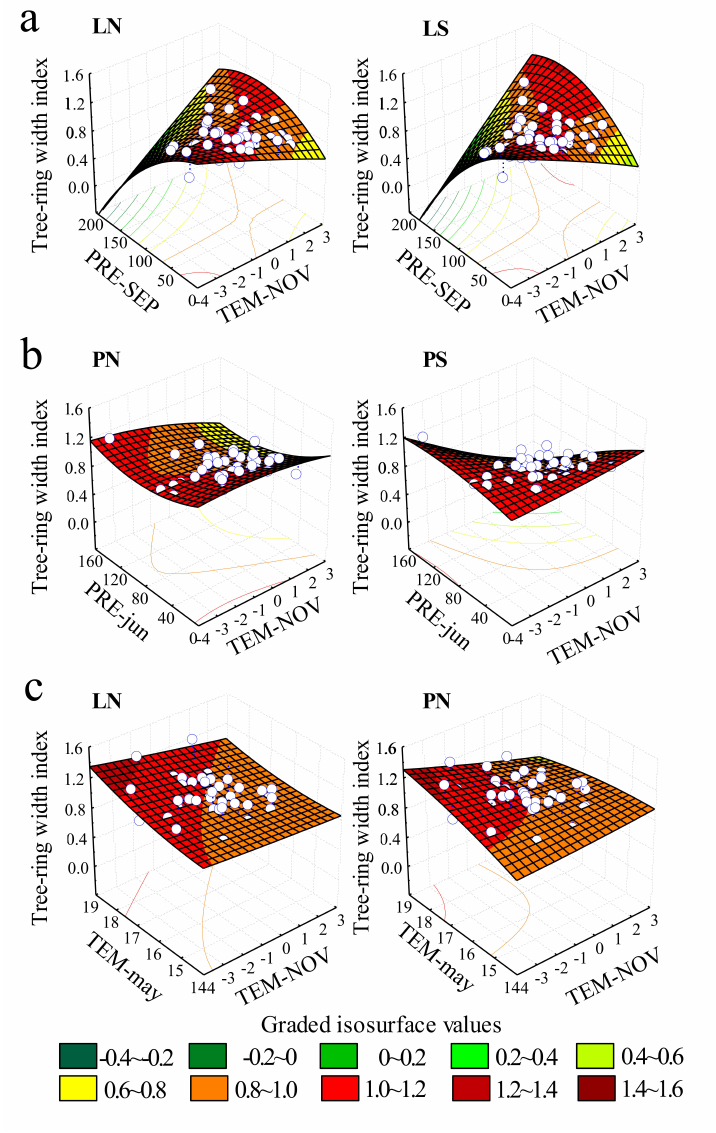
Figure 4. Results of response surface analysis for the two species on opposite slope aspects. The white points represent the tree-ring width index data for each year from 1958 to 2007. The capitalized months denote months belonging to the previous year. The prefix “PRE” indicates total monthly precipitation and “TEM” indicates monthly mean